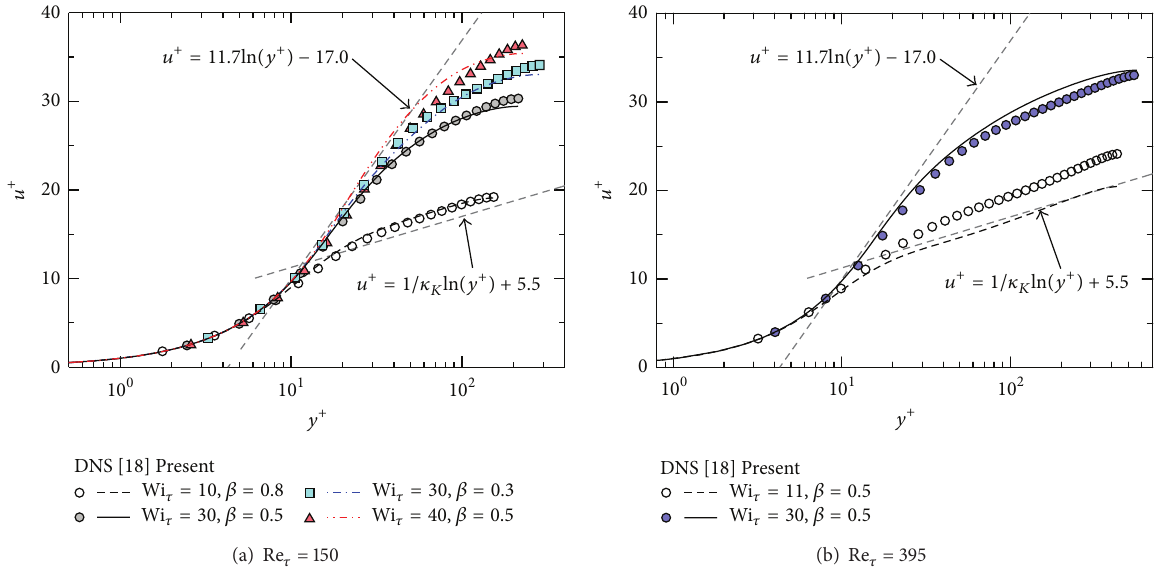
Figure 6: Mean velocity profiles in wall coordinates. Comparison between the model prediction and the corresponding DNS data [18]. Table 2: Effective wall viscosity normalized by 𝜇 0 .